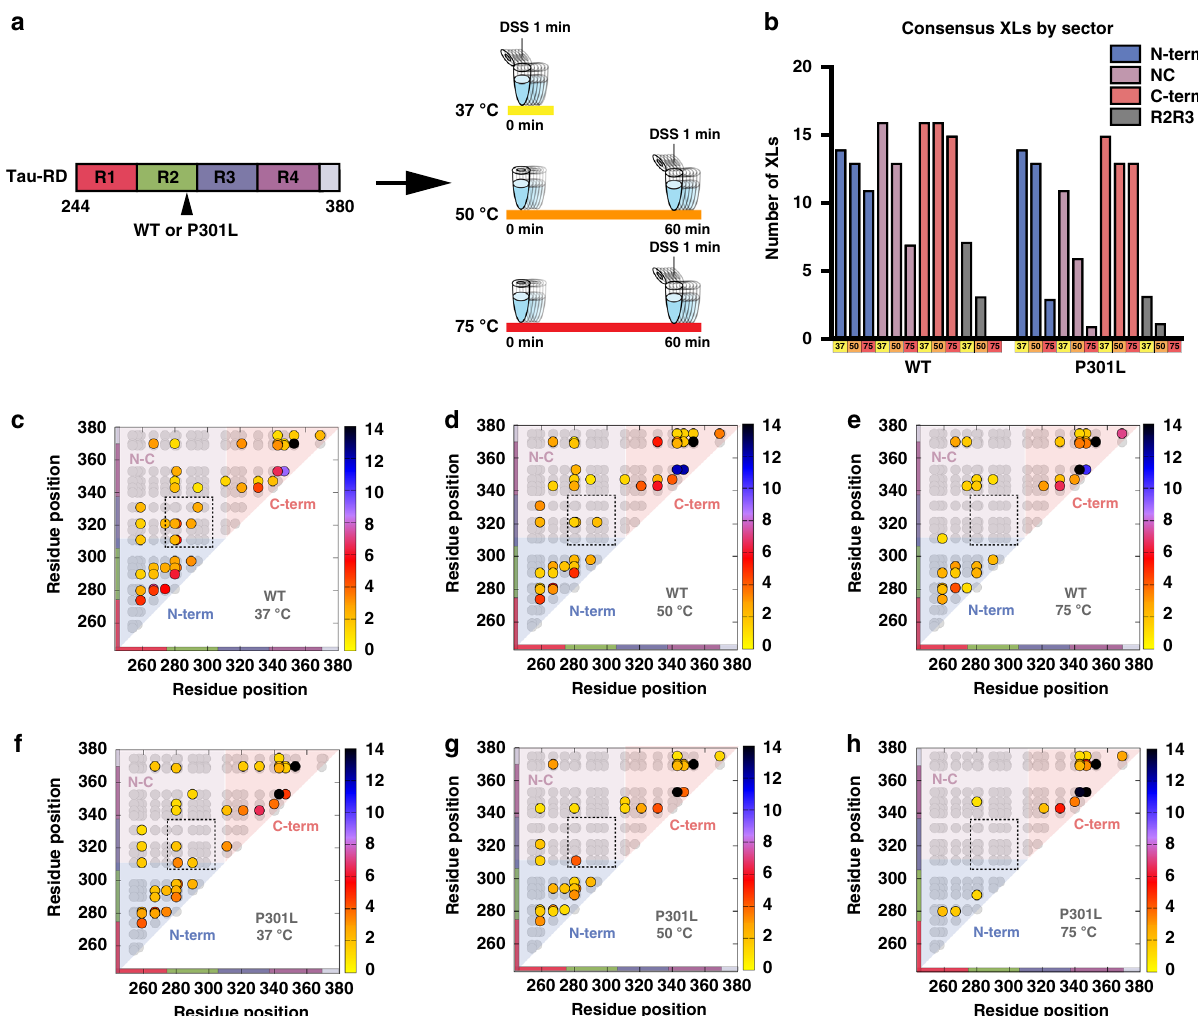
Fig. 2 Tau RD encodes global and local structure. a Cartoon schematic of tau RD used for XL-MS studies colored according to repeat domain. Recombinant WT and P301L tau RD were heated at 37 °C, 50 °C or 75 °C for 1 hour, then chemically cross-linked using DSS. After cross-linking, trypsin fragmentation, and LC-MS/MS analysis were performed. Each sample was carried out in fi ve technical replicates. b Total consensus cross-links parsed by temperature and location in WT and P301L tau RD: within N-terminus (blue; residues 243 – 310; N-term), within C-terminus (orange; residues 311 – 380; C-term), span N- and C-terminus (magenta; between residues 243 – 310 and 311 – 380; N-C) and between repeat 2 and repeat 3 (R2R3) (gray; between residues 275 – 305 and 306 – 336). c – e Consensus cross-links (circles) are shown in contact maps color coded by average frequency across replicates. The theoretical lysine pairs are shown in the background as gray circles. Cross-link contacts within the N-term (blue), C-term (red), and across N- to C-term (purple) are shown as sectors. The x and y axis are colored according to repeat number as in Fig. 1. The dashed boxes de fi ne inter-repeat cross-links observed between repeat 2 and repeat 3. f – h Same as c – e above, except with tau RD that contains a P301L mutation disuccinimidyl suberate (DSS; a primary amine crosslinker) for represent only a small subset of all theoretical lysine pairs sug- 1 min and quenched (Fig. 2a). The cross-linked protein mono- gesting that tau RD samples have discrete modes of contacts mers were con fi rmed by sodium dodecyl sulfate polyacrylamide (Fig. 2c, gray circles). Heating the samples to 50 °C or even 75 °C gel electrophoresis (Supplementary Figure 2a). Cross-linked decreased the number of N-C long-range and N-term short-range samples were trypsin digested, analyzed by mass spectrometry contacts identi fi ed (Fig. 2b, d, e and Supplementary Figure 2b). and the spectra were searched using Xquest 39 to identify intra- molecular protein contact pairs (Methods and Supplementary Data 3). In each data set, the cross-links reported represent consensus data across fi ve independent samples with a low false discovery rate (FDR) (Methods, Supplementary Figure 3 and Supplementary Data 4). XL-MS of recombinant WT tau RD acquired at 37 °C revealed three clusters of interactions that localize within the N-terminus (residues 243 – 310; N-term), within the C-terminus (residues 311 – 380; C-term) and span N- and C-termini (N – C; between residues 243 – 310 and 311 – 380) (Fig. 2b, c). Importantly, the experimentally observed cross-links NATURE COMMUNICATIONS| (2019) 10:2493